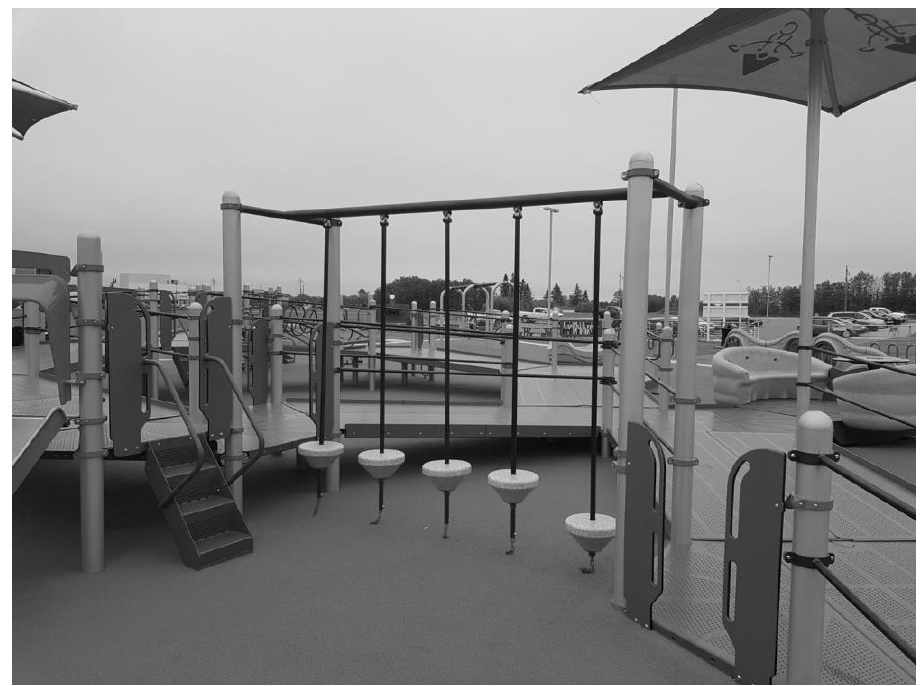
Figure 4. Image depicting part of the main structure section of the observed playground.